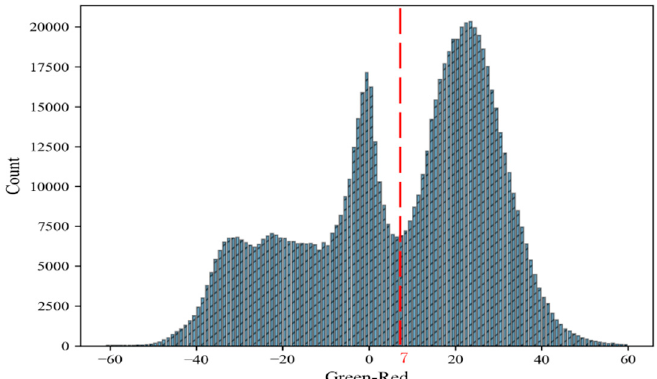
Figure 3. Histogram of mean G-R difference for point cloud in three periods (T1, T2, T3). The red dotted line is value 7 of (G-R), separating plants from soils and shadows.